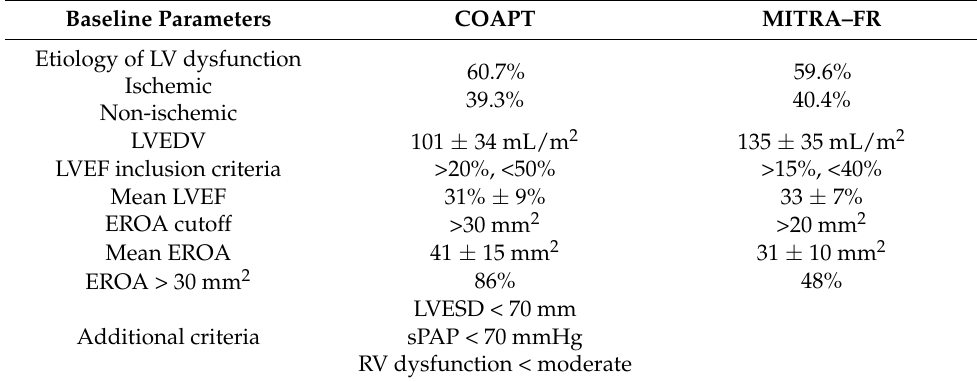
Table 5. Main echocardiographic differences between the two study